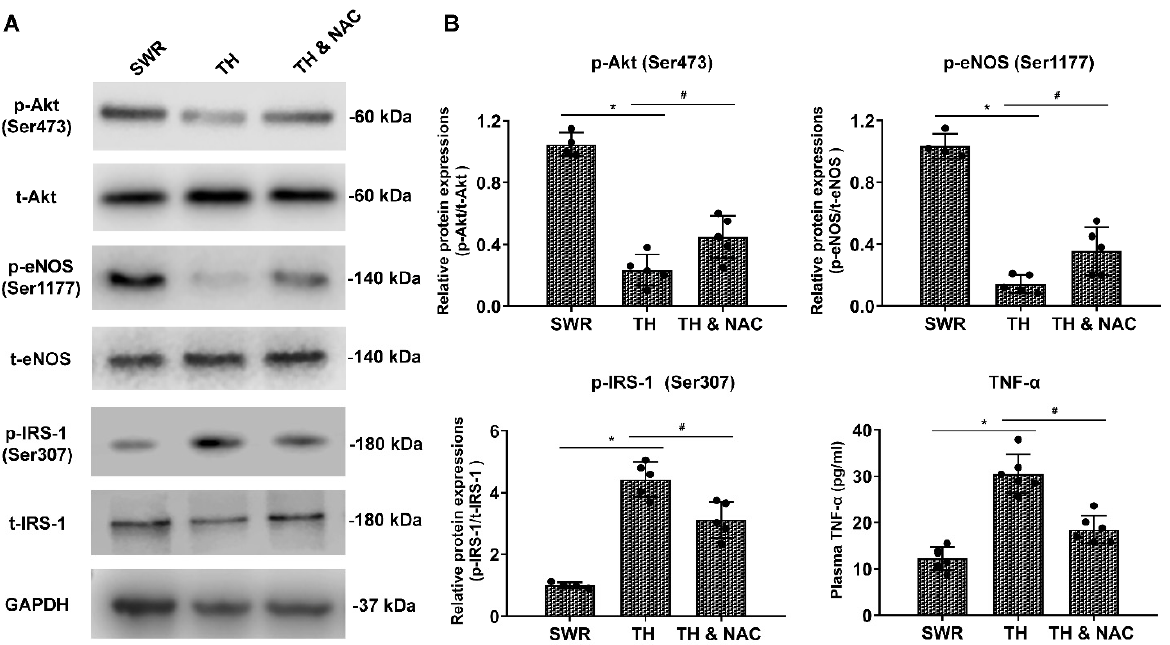
Figure 7. NAC treatment increased the phosphorylation of Akt (Ser473) and eNOS (Ser1177) expression, while decreasing plasma TNF-a and phosphorylated IRS-1 (Ser307) expression in diabetic ischemic limbs. As shown in panels ( A , B ), levels of p-IRS-1 and TNF- α were significantly increased together with a decrease in total IRS-1 compared to those of non-diabetic controls. NAC treatment partially, but significantly, reversed the changes in p-IRS-1 and TNF- α ( n = 4–6, # p < 0.05 for TH versus TH & NAC, * p < 0.01 for TH versus SWR). In addition, the expression of p-Akt and p-eNOS was markedly decreased in the ischemic muscle tissue of diabetic mice without apparent changes in either total Akt or eNOS levels. NAC treatment significantly improved the levels of p-Akt and p-eNOS in diabetic ischemic limbs ( n = 4–6, # p < 0.05 for TH versus TH & NAC, * p < 0.01 for TH versus SWR). IRS-1, insulin receptor substrate 1; GAPDH, glyceraldehyde 3-phosphate dehydrogenase; TH, diabetic TALLYHO/JngJ mice with CLI operation; SWR, non-diabetic SWR/J mice with CLI operation; TH & NAC, TALLYHO/JngJ mice with CLI operation plus NAC treatment. All data are shown as means ± SD. Significant differences were determined with one-way ANOVA with Bonferroni’s post hoc test or Kruskal-Wallis test with Dunn post hoc test.